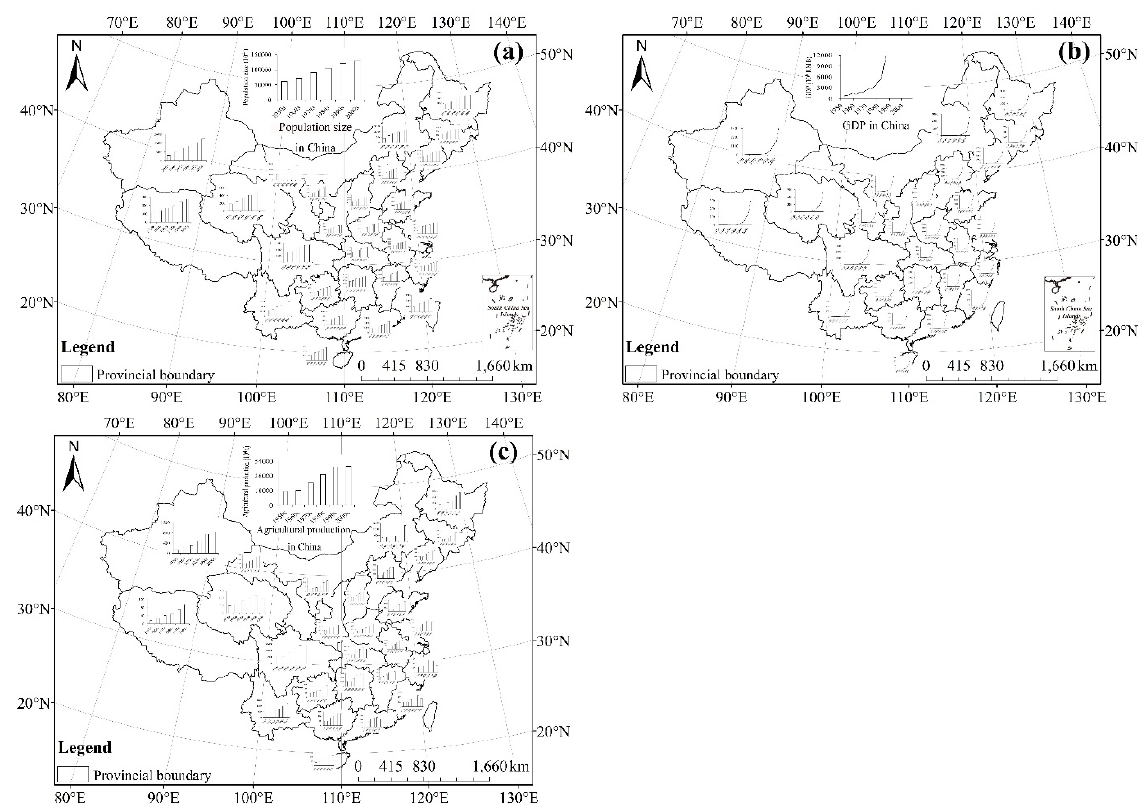
Figure 9. ( a ) Interannual variability of population; ( b ) gross domestic product (GDP); and ( c ) agricultural products in 1950–2012 in